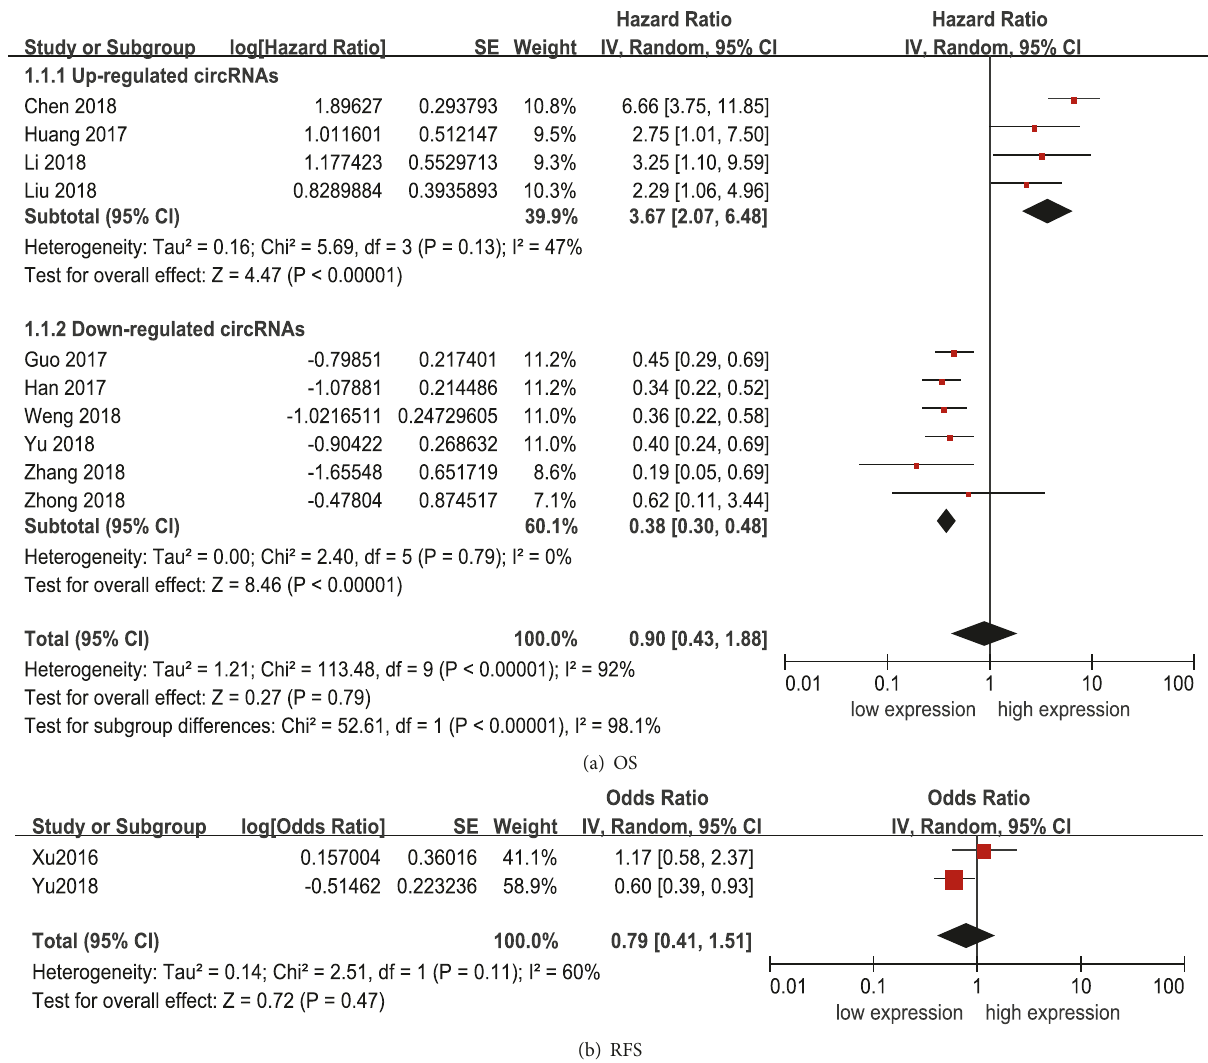
Figure 6: Forest plot for the association between altered cirRNAs expression and survival in HCC. (a) Association with overall survival; (b) association with recurrence free survival. SE, standard error; IV, inverse variance methods; HR, hazard ratio; CI, confidence interval.